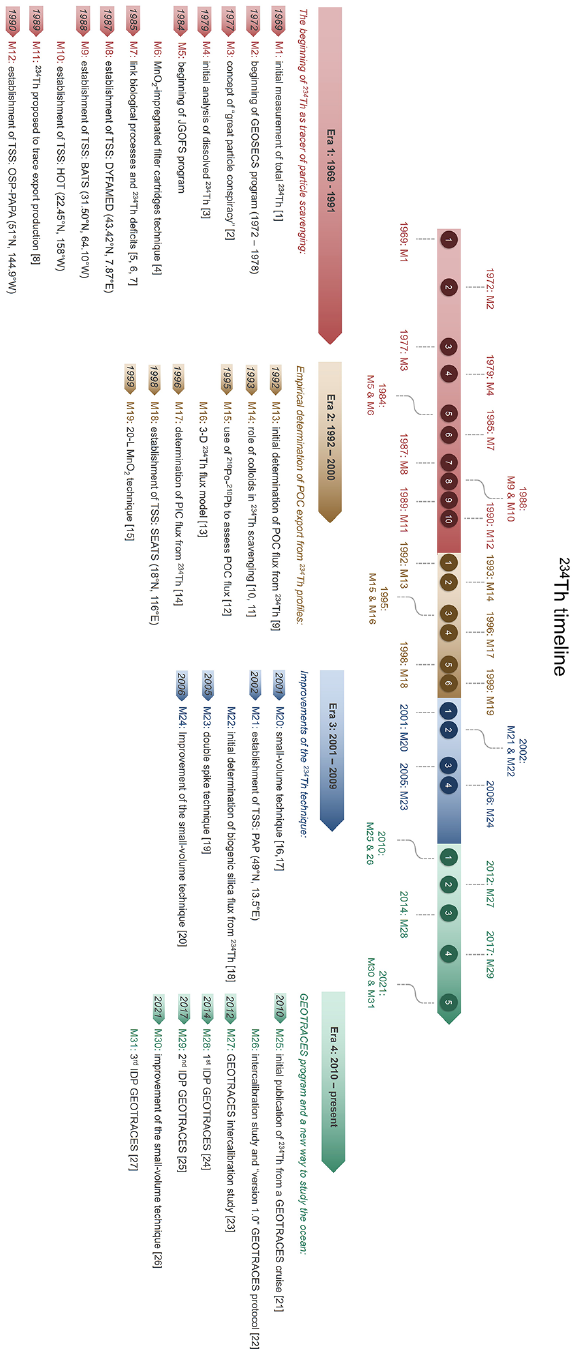
Figure 3. Summary of 234 Th timeline. The 50 years of 234 Th data have been divided into four eras whose beginning has been defined based on seminal 234 Th-related publications that changed the course of the technique. Important years within eras are marked with circles and numerated by era. For each era, key milestones are indicated, with cumulative numeration along the timeline. A brief description of each milestone is also provided. Numbers in brackets denote the following references: [1] Bhat et al. (1969), [2] Turekian (1977), [3] Santschi et al. (1979), [4] Mann et al. (1984), [5] Coale and Bruland (1985), [6] Bruland and Coale (1986), [7] Coale and Bruland (1987), [8] Epp- ley (1989), [9] Buesseler et al. (1992), [10] Baskaran et al. (1992), [11] Moran and Buesseler (1993), [12] Shimmield et al. (1995), [13] Bues- seler et al. (1995), [14] Bacon et al. (1996), [15] Rutgers van der Loeff and Moore (1999), [16] Buesseler et al. (2001b), [17] Benitez-Nelson et al. (2001), [18] Friedrich and Rutgers van der Loeff (2002a), [19] Pike et al. (2005), [20] Cai et al. (2006b), [21] Cai et al. (2010), [22] Cutter et al. (2010), [23] Maiti et al. (2012), [24] Mawji et al. (2015), [25] Schlitzer et al. (2018), [26] Clevenger et al. (2021), and [27] GEOTRACES Intermediate Data Product Group